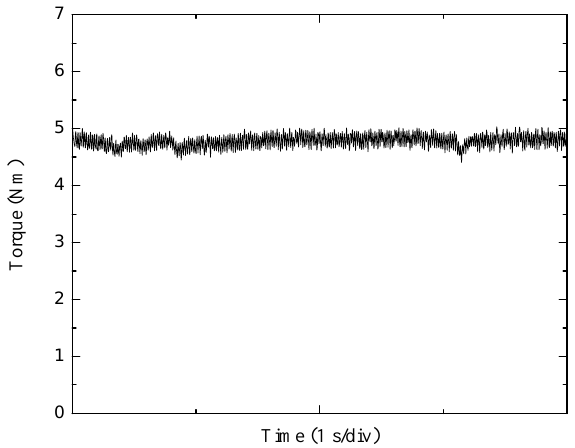
Figure 15. Phase– a current and hall– a signal under 5 N · m load with 25 ◦ reference delay angle.